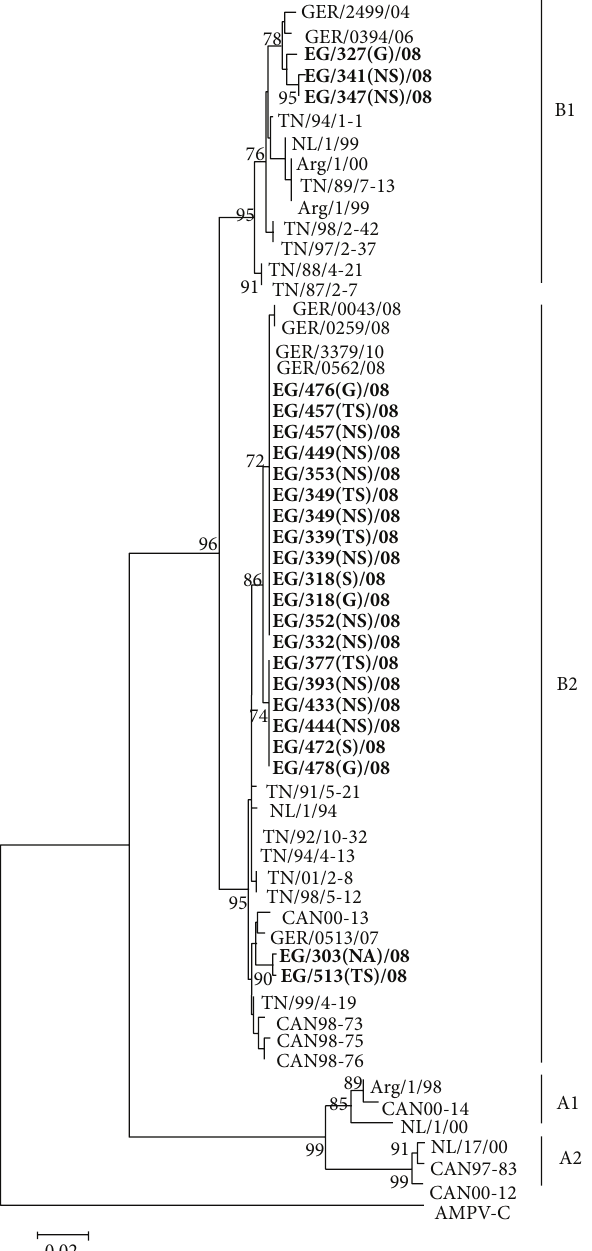
Figure 3: Phylogenetic tree of partial F gene sequences of Egyptian HMPV. The tree was generated with Neighbor-Joining method with 1,000 bootstrap replicates and rooted to Avian metapneumovirus C (AMPV-C). Reference sequences representing the different HMPV genetic lineages were additionally included in the analysis. Egyptian viruses are shown in boldface. These viruses are identified by the geographic location, patient number, type of specimen, and year of isolation. The scale bar represents 2% of nucleotide changes between close